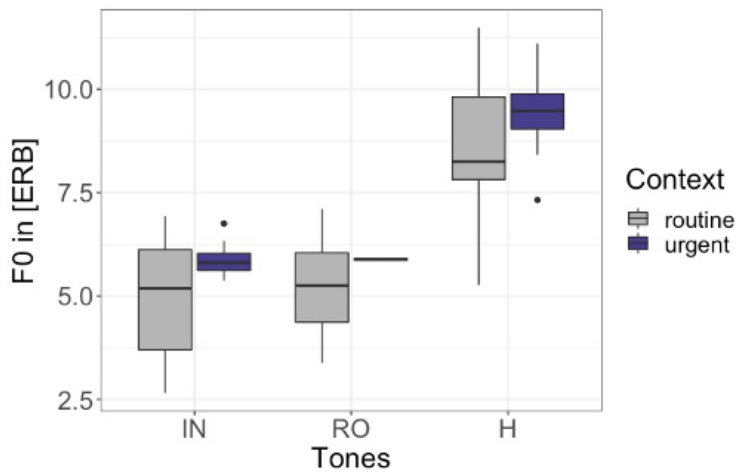
Figure 7. F0 scaling of the rising contour in the routine and urgent context in MF.